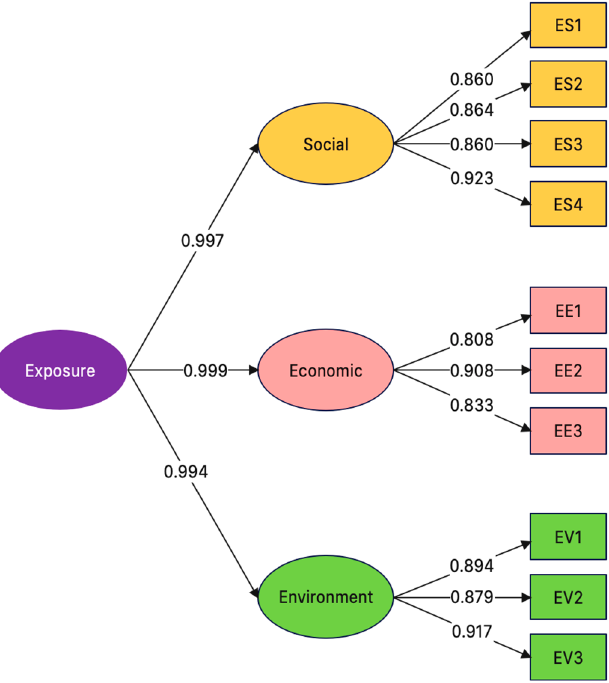
Figure 3. Structural equation model and the factor loadings of UHI exposure indicators and dimen- sions.